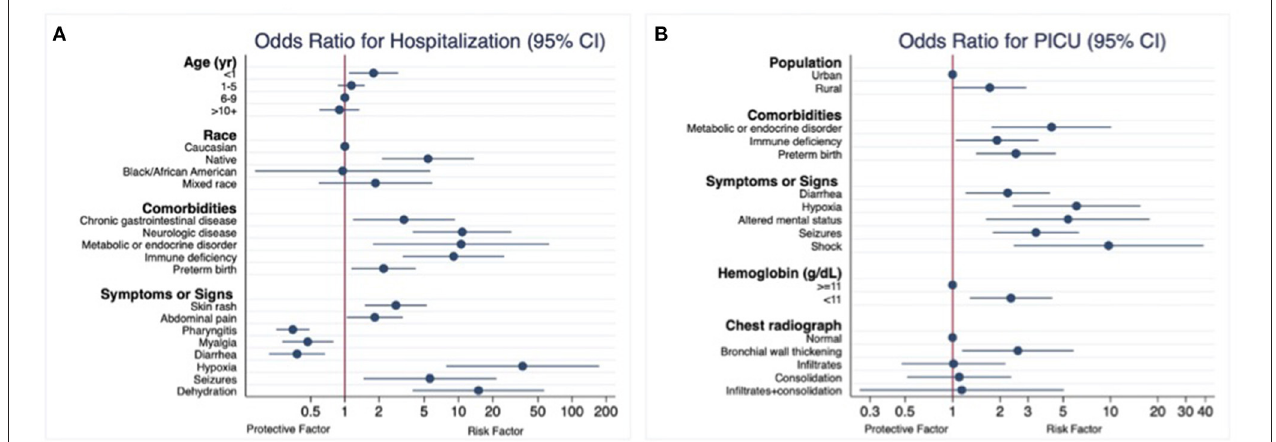
FIGURE 2 | Risk factors among pediatric patients with COVID-19. Multiple imputation chained equations for missing data. (A) Hospital admission (general pediatric ward or pediatric intensive care unit). (B) Pediatric intensive care admission among hospitalized patients.